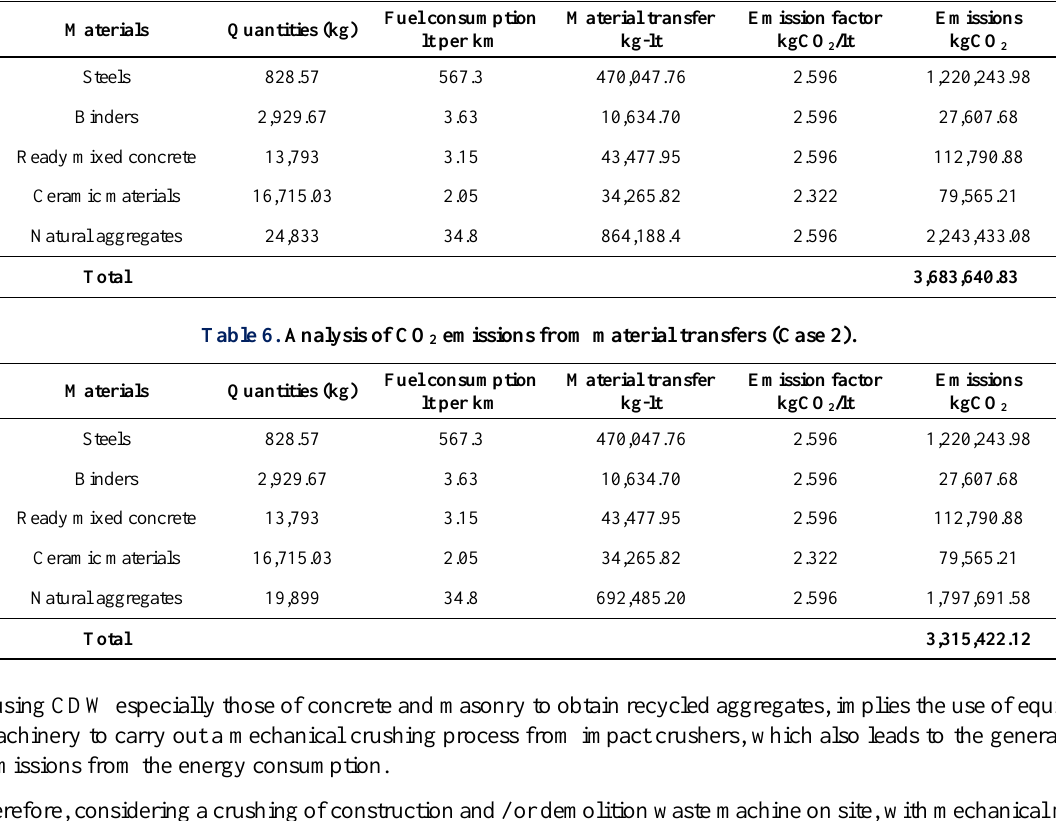
Table 5. Analysis of CO 2 emissions from material transfers (Case 1).